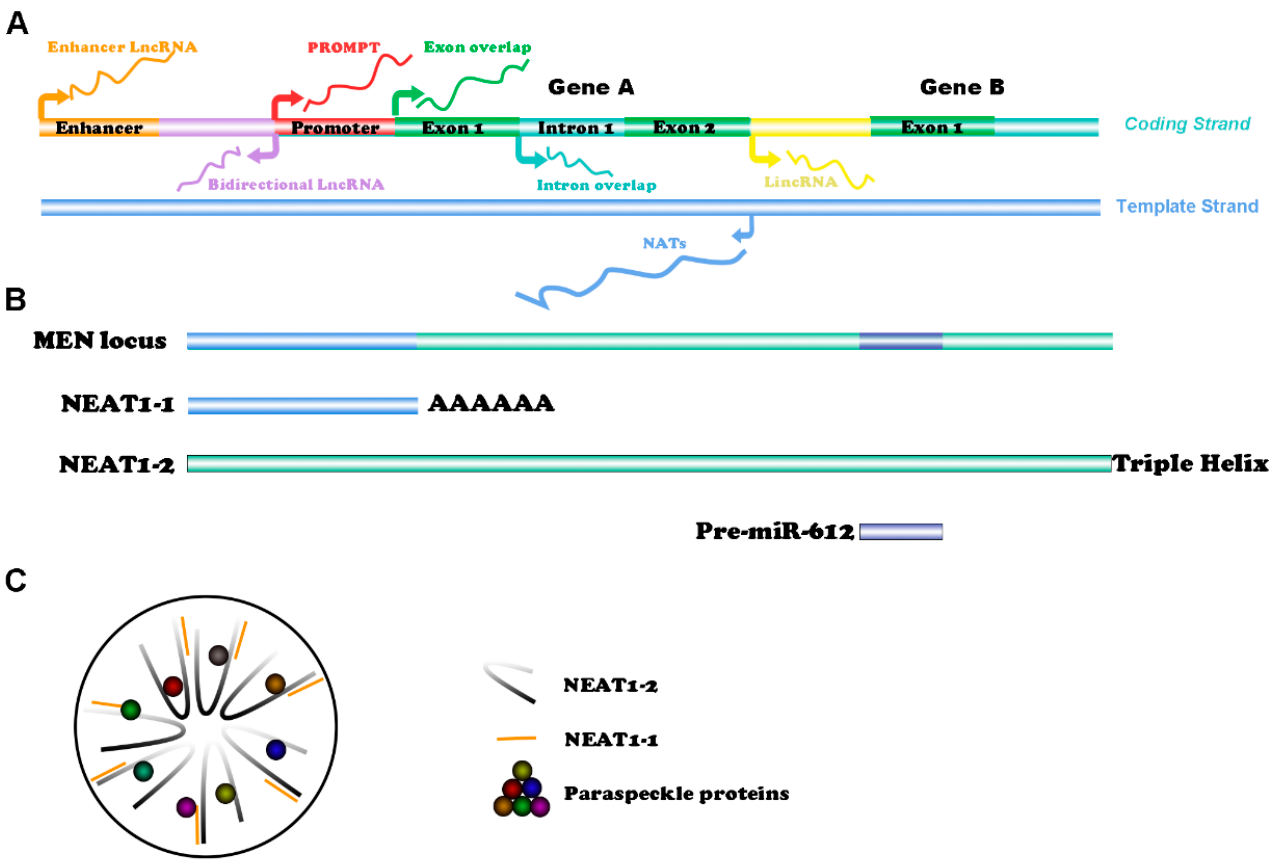
Figure 1. Classification of lncRNAs and structure of NEAT1: ( A ) LncRNAs can be categorized as enhancer lncRNAs, promoter upstream transcripts (PROMPTs), exon or intron sense-overlapping lncRNAs, long intergenic ncRNAs (lincRNAs), bidirectional lncRNAs, and natural antisense transcripts (NATs); ( B ) Locations of NEAT1-1, NEAT1-2, and Pre-miR-612 at the MEN locus; ( C ) Cross-sectional structure of paraspeckles.